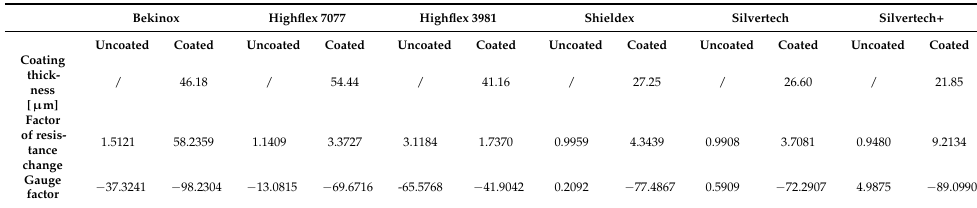
Table 4. Summary of